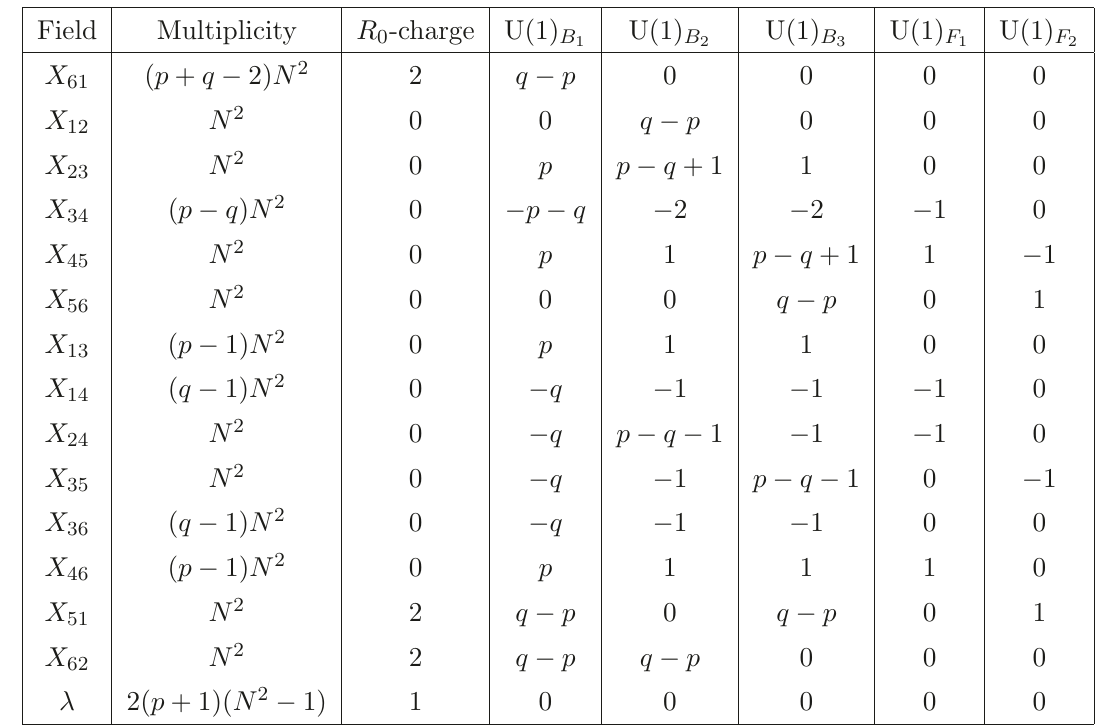
Table 4 . The field content of the Z p,q quiver